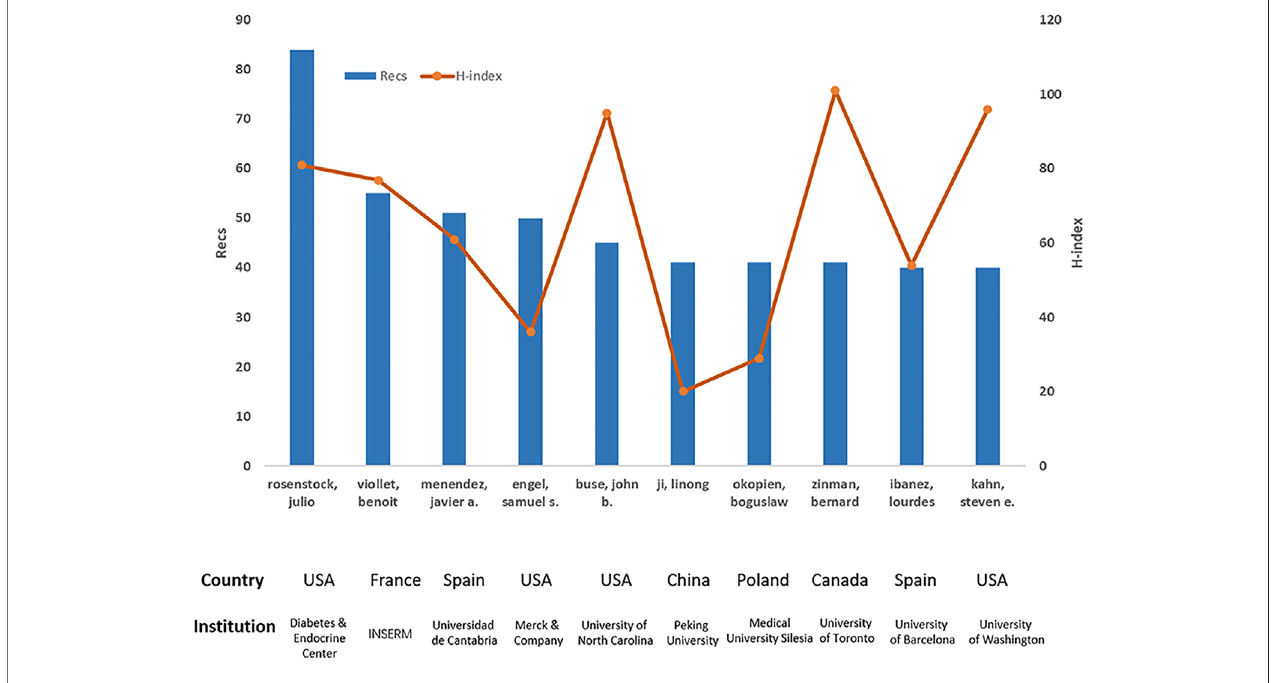
FIGURE 4 | The top 10 most productive authors in metformin research area.